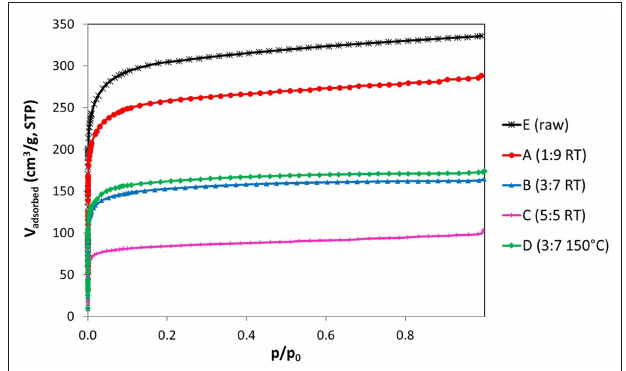
TABLE 3 | Textural parameters obtained from the N 2 and CO 2 adsorption isotherms at − 196 and 0 ◦ C, respectively.